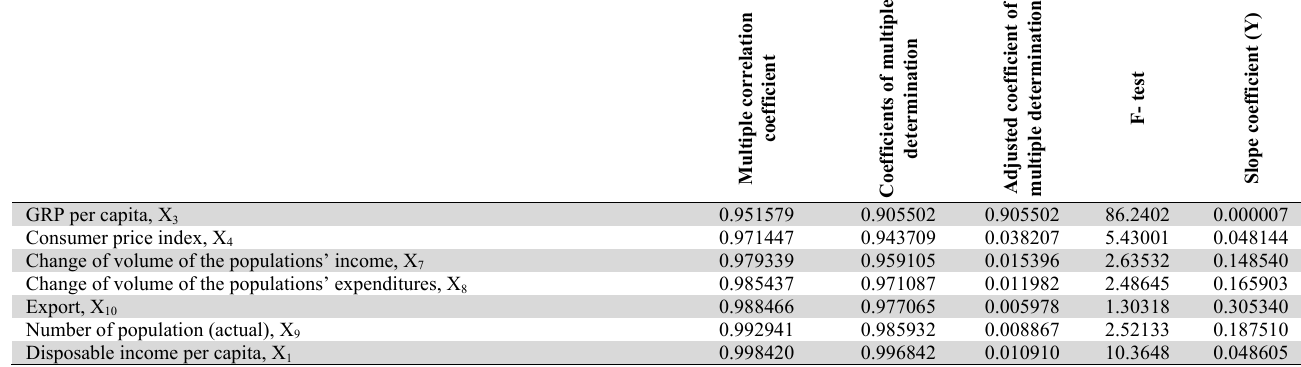
Results of the reliability of the constructed multiple regression equation for the regional consumer market capacity in Ivano- Frankivska